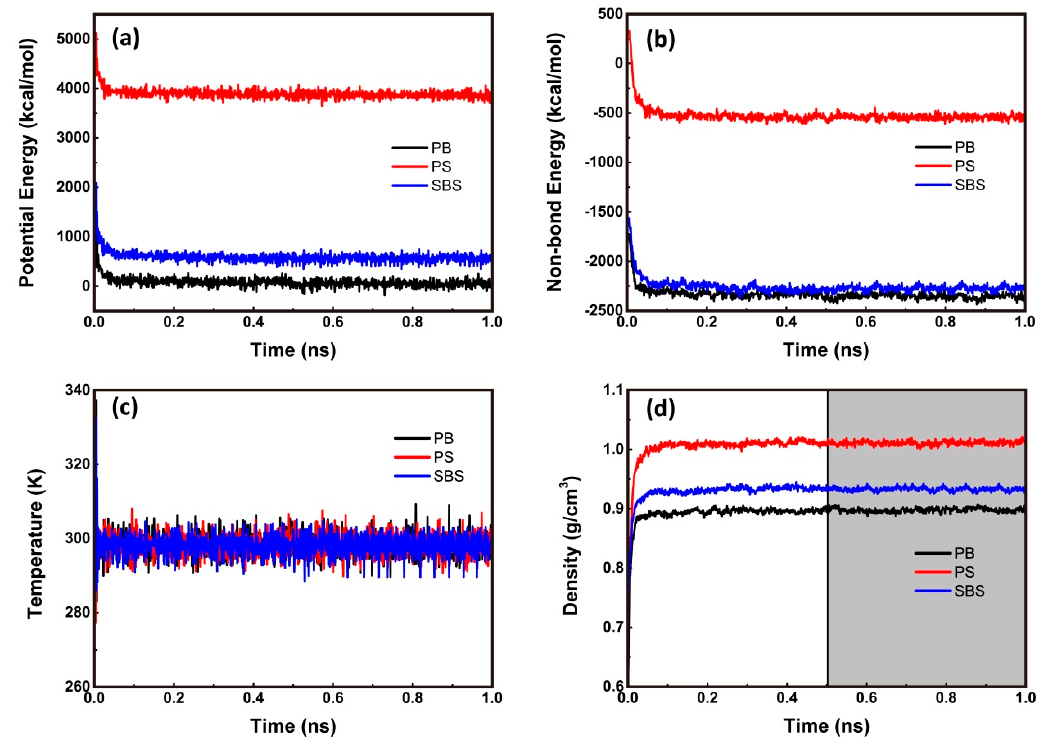
Figure 2. Historical curves of physical properties of systems. ( a ) Total potential energy (i.e., Equation (1)) (kcal / mol), ( b ) non-bonded energy (kcal / mol), ( c ) temperature (K), and ( d ) density (g / cm 3 ). The mean values of density of PB / PS / SBS were obtained between 0.5 ns and 1.0 ns (the grey region)) at T = 298.15 K and P = 1 atm. Table 2. Densities of PB, PS, and SBS system from simulations and experiments at T = 298.15 K, P = 1 atm Density (cid:2761) (g/cm 3 ) Polymer